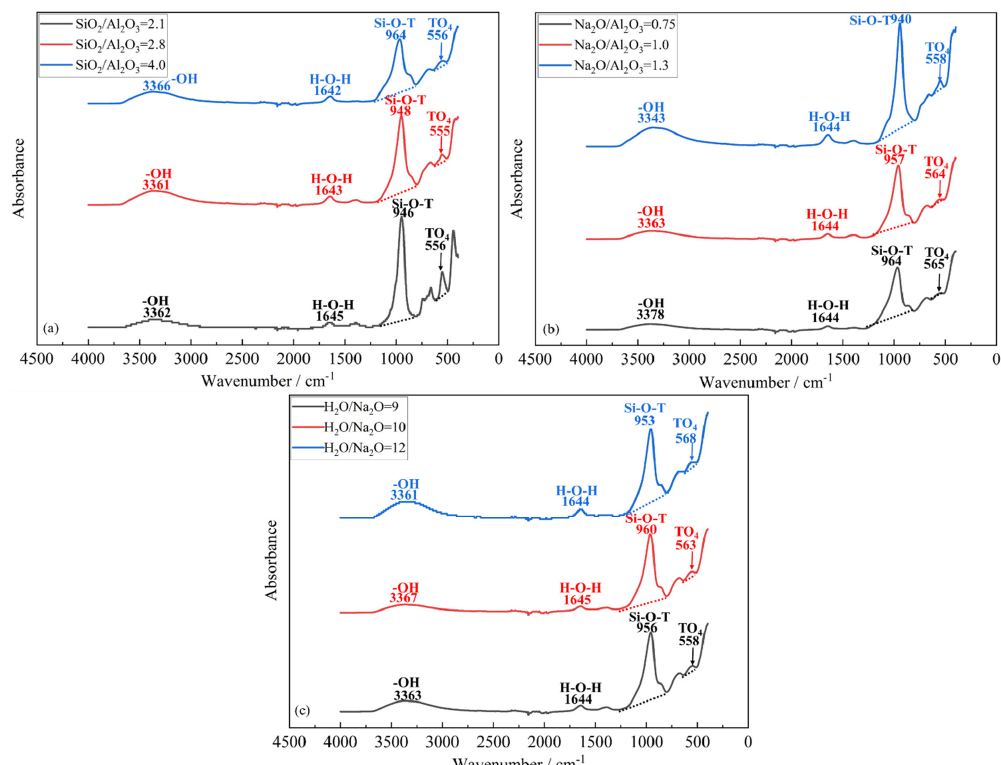
Figure 6. FTIR spectra of hardened geopolymers made with varying ( a ) SiO 2 /Al 2 O 3 , ( b ) Na 2 O/Al 2 O 3 and ( c ) H 2 O/Na 2 O molar ratios.